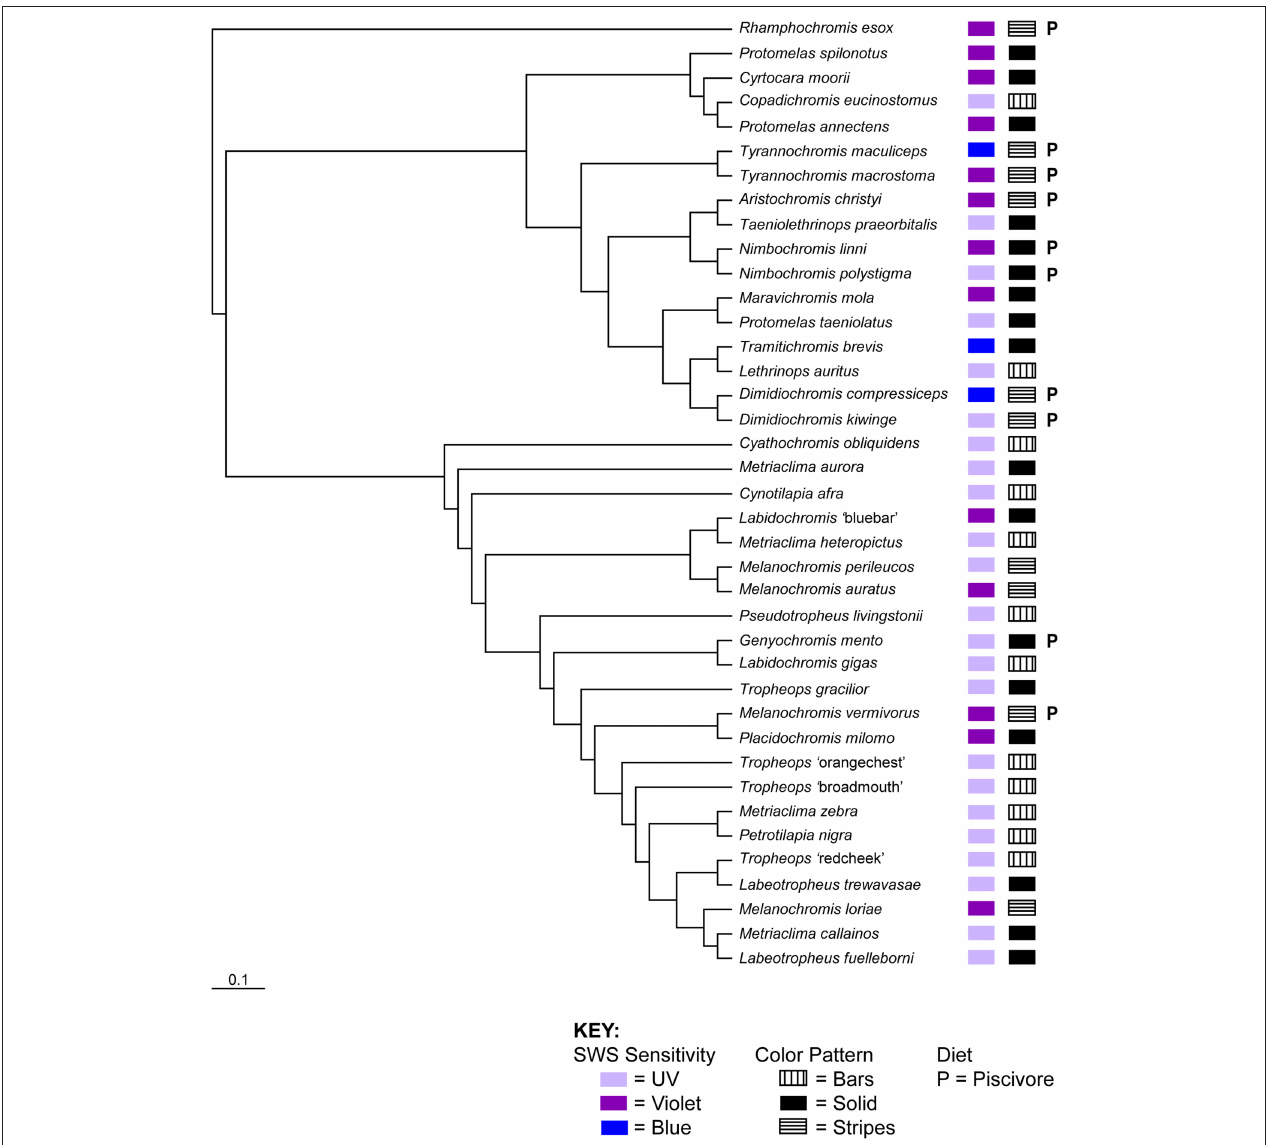
FIGURE 2 | One example of the 1000 trees generated from the phylogeny in Figure 1, with color pattern (vertical bars, solid patches, or horizontal stripes), SWS sensitivity (UV vs. non-UV), and dietary (piscivorous vs. non-piscivorous) characteristics mapped onto the phylogeny for each species.